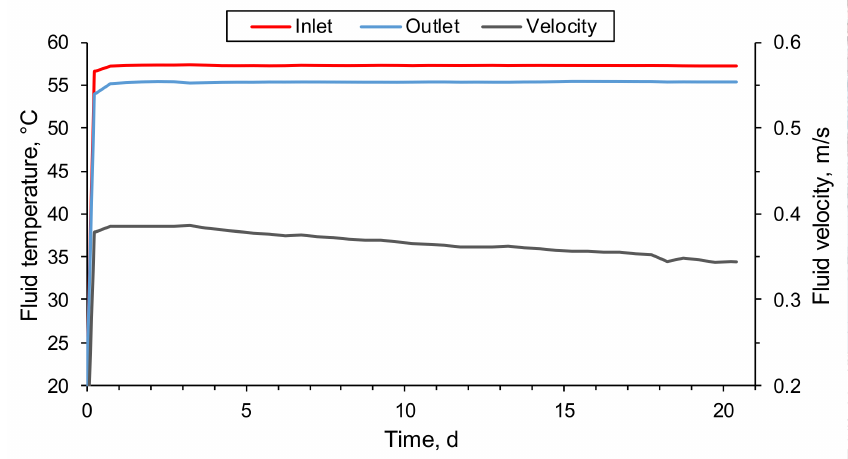
Figure 4. The measured temperature of the carrier fluid at the inlet and outlet, averaged per hour, and the fluid velocity calculated from the flow meter